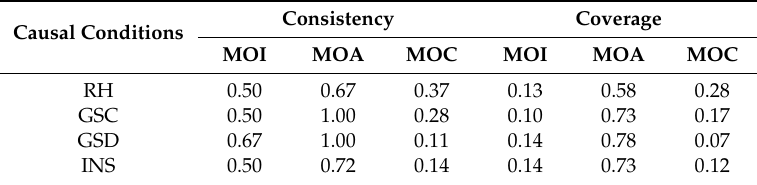
Table 6. Analysis of the necessity of single causal conditions.